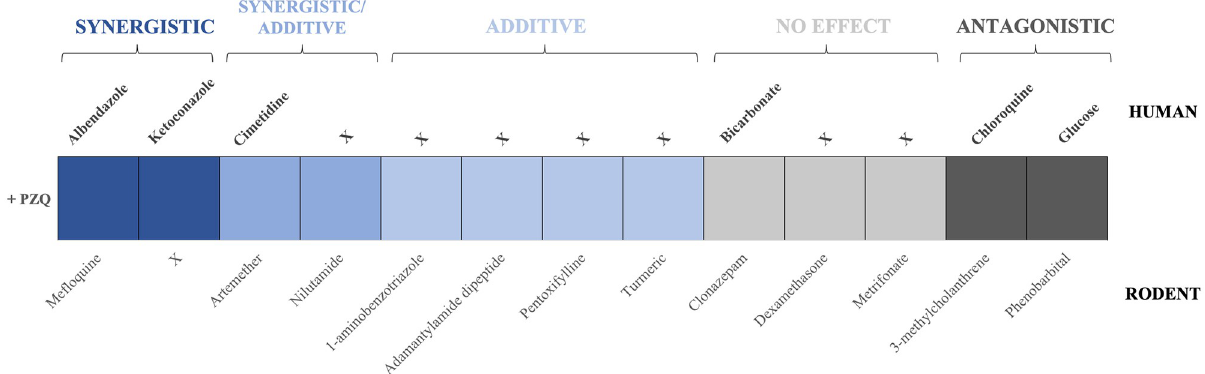
Fig 5. The DDIs identified by the review, and the resultant effect on PZQ exposure. The in vivo model and “Drug B” are listed as well as the overall effect of the drug combination on exposure of PZQ. The effect of the drug combination on PZQ efficacy in rodents was calculated based on the percentage change in WBR of each drug alone in comparison to the combined action (S9 Table) [73–83]. The effect of the drug combination on PZQ efficacy in humans was calculated based on the percentage change in AUC of each drug alone in comparison to the combined action (S10 Table) [54, 59, 84–86]. AUC, area under the curve; DDI, drug–drug interaction; PZQ, praziquantel; WBR, worm burden